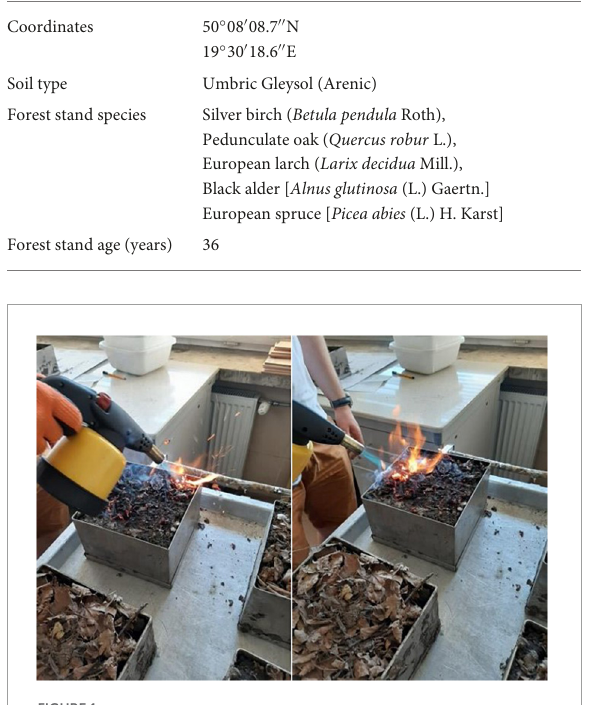
FIGURE1 Burning of soil samples. Photographs by Anna Klamerus-Iwan.